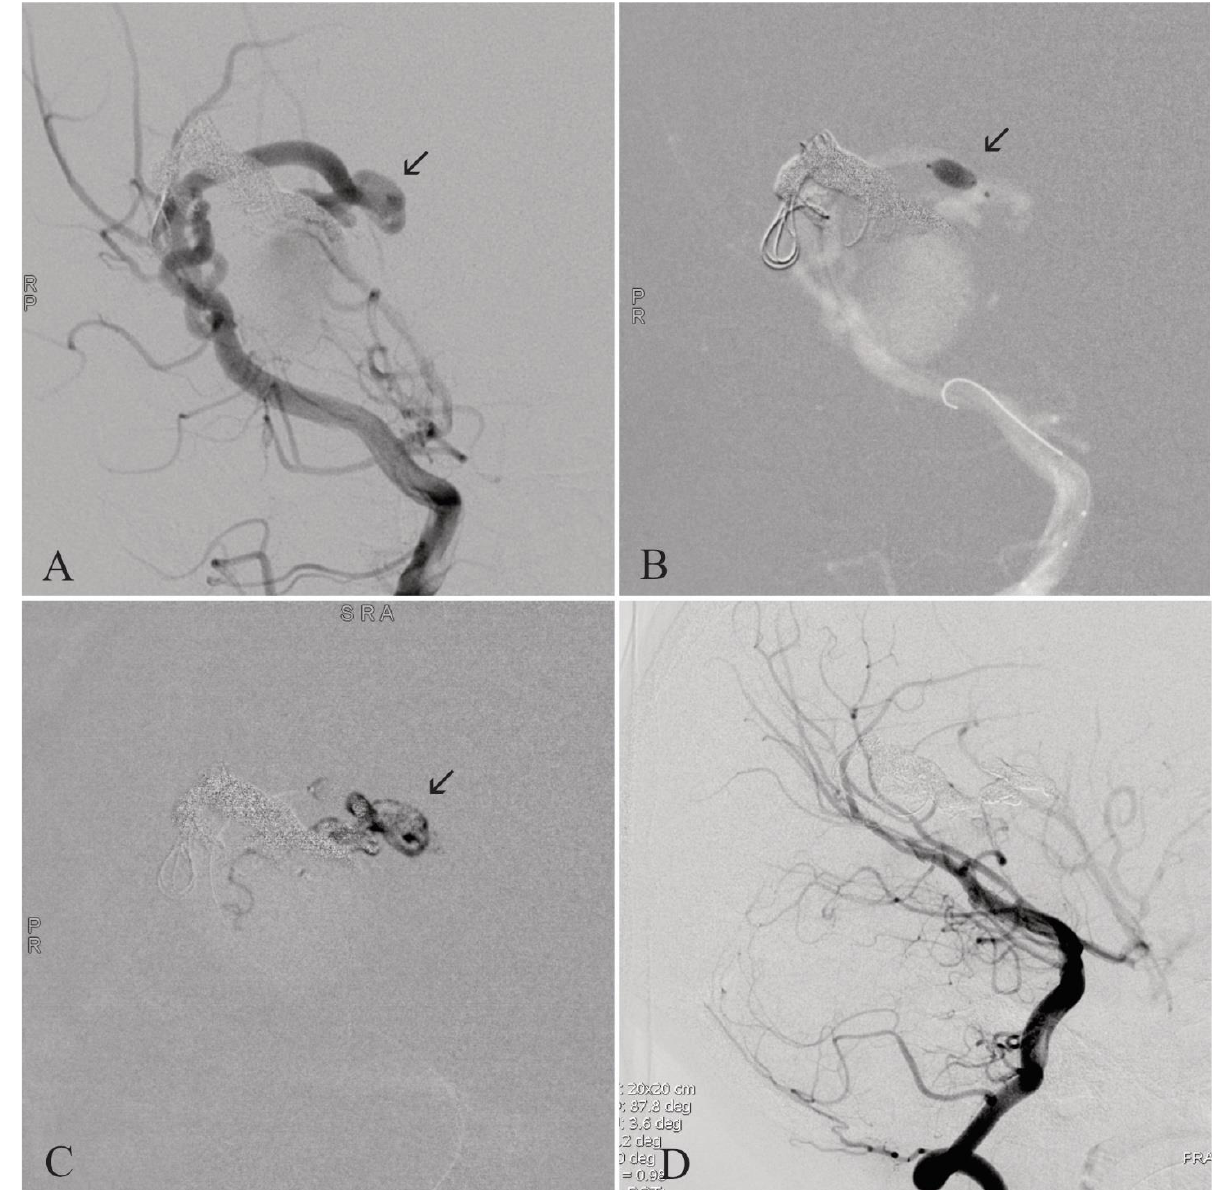
Figure 2 - (A) DSA lateral view of the left vertebral artery showing the remnant mural shunt of the posterior choroidal artery to the VGOM, (B) Roadmap lateral view showing the DLB (black arrow) inflated and occluding the posterior choroidal branch, (C) Roadmap lateral view showing the injection of EVOH (black arrow) through the inflated DLB, (D) DSA lateral view of the left vertebral artery showing a complete occlusion of the posterior choroidal